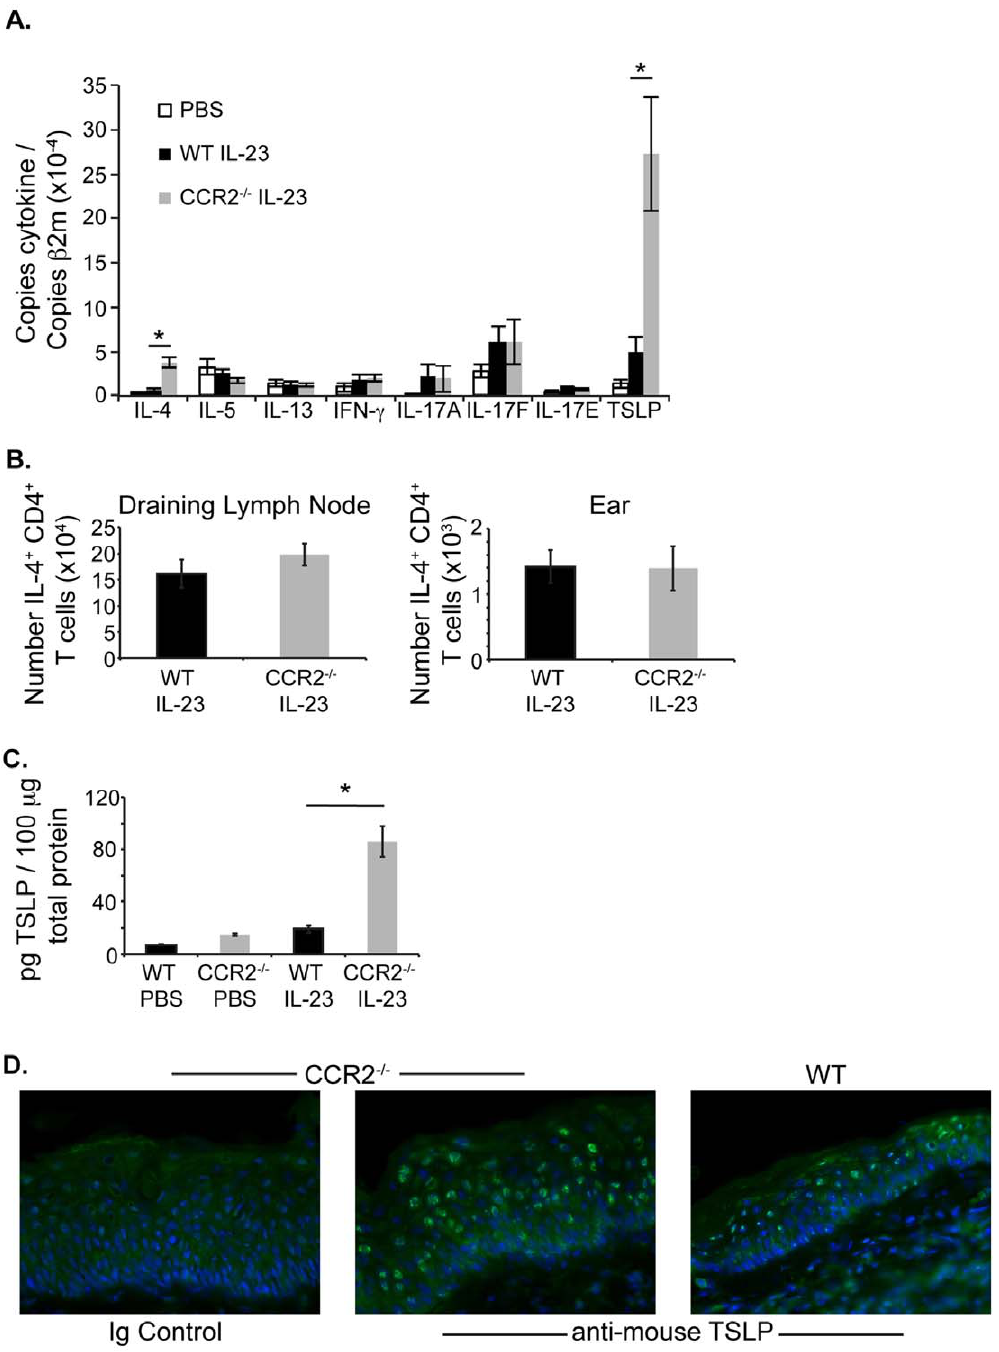
Figure 6. Increased TSLP and IL-4 in ears of IL-23-injected CCR2 2 / 2 compared to WT mice. On day 12, ( A ) mRNA of indicated cytokines was measured by real-time RT-PCR from ears of WT PBS-injected or WT and CCR2 2 / 2 IL-23-injected mice. Average of 11 mice per genotype in 3 experiments. *p , 0.01. ( B ) Intracellular cytokine staining for IL-4 on gated CD3 + CD4 + T cells following stimulation with PMA and ionomycin was performed and day 12 and analyzed by flow cytometry. Number of IL-4 + CD3 + CD4 + T cells in draining lymph node (left panel) or IL-23-injected ear (right panel). ( C ) TSLP was measured by tissue ELISA of ears isolated from PBS-injected or IL-23-injected WT and CCR2 2 / 2 mice. Average of 3 mice per genotype. *p , 0.005 CCR2 KO IL-23 vs. all other groups. ( D ) Representative immunofluorescence staining of ear skin isolated on day 12 from IL-23- injected WT C57Bl/6 or CCR2 2 / 2 mice. Sections were stained with Ig isotype control antibody or anti-TSLP (x600, original magnification). Data are reflective of 3 mice per genotype.